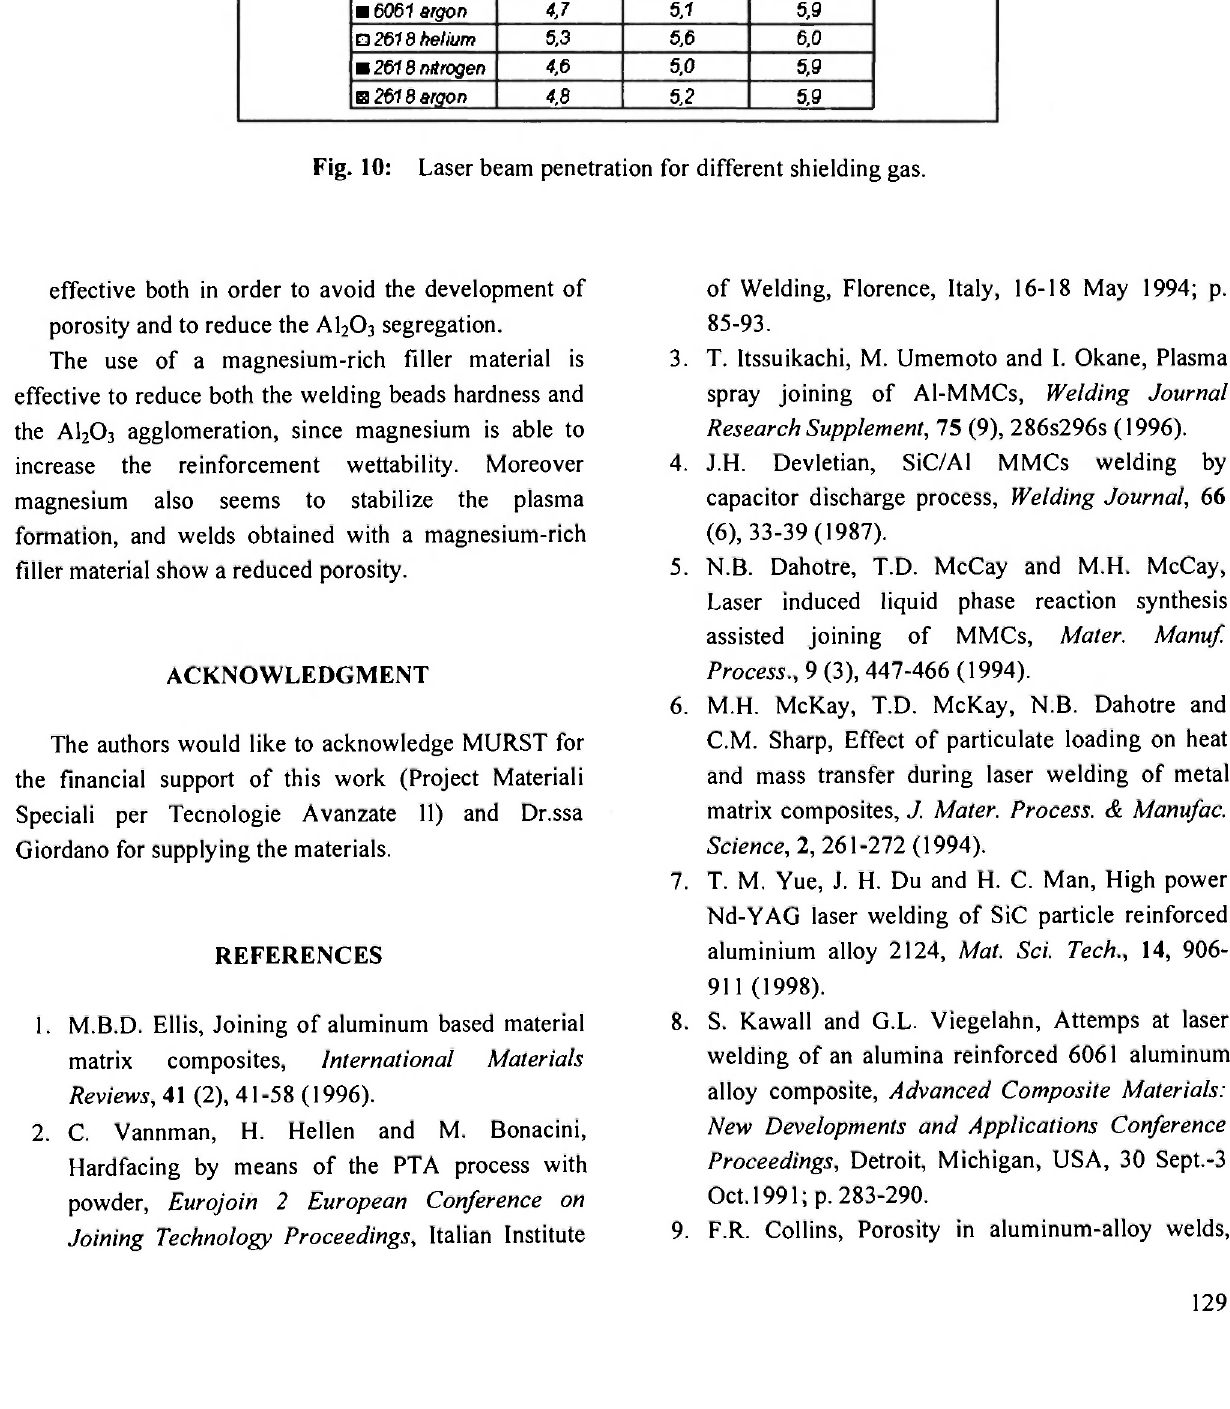
Fig. 10: Laser beam penetration for different shielding